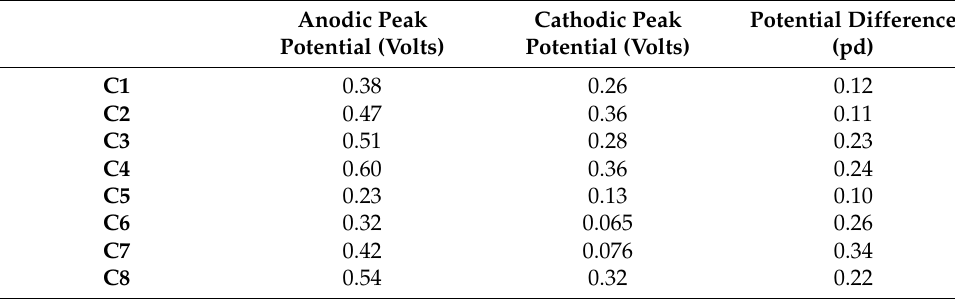
Table 5. Summary of electrochemical data for C1–C8 a